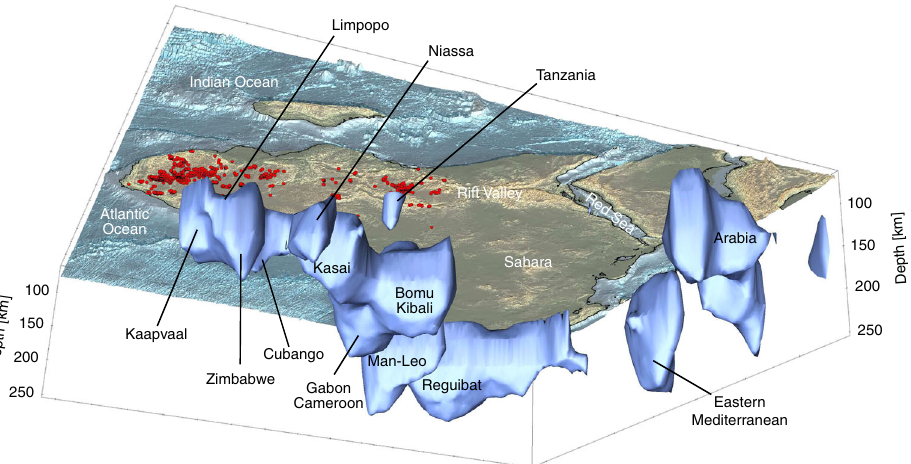
Fig. 2 Three-dimensional representation of cratonic lithosphere in the tomographic model. The view is looking up and to the northwest from beneath the southern Indian Ocean. The + 5% δ V S contour, plotted between 80 and 260 km depths, encloses the nuclei of the cratonic lithosphere. The bottom of the nuclei is not the lithosphere-asthenosphere boundary (that would be closer to 0% δ V S ), but thicker nuclei do indicate thicker cratonic lithosphere. The Eastern Mediterranean anomaly comprises the thick, Triassic oceanic lithosphere 67 and a portion of the Hellenic subducting slab. Subduction is also seen beneath and to the north-east of Arabia. Kimberlite and lamproite locations are shown as red